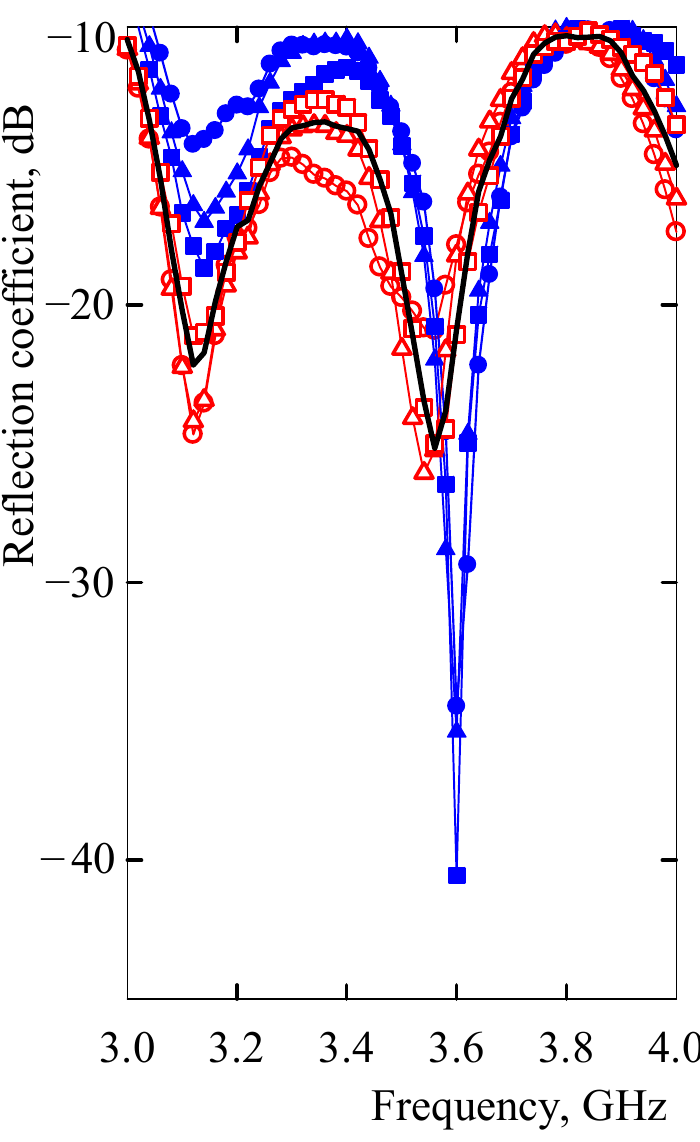
Figure 11. The reflection coefficient spectrum of the microstrip resonant sensor after exposure to saturated non-polar vapors (heptane, toluene, and pentane) and polar vapors (methanol, ethanol, and acetone) for 120 s. Filled circles, triangles, and squares denote heptane, toluene, and pentane, respectively. Open circles, triangles, and squares denote ethanol, acetone, and methanol, respectively. The black solid line represents the reflection coefficient spectrum unaffected by vapors.